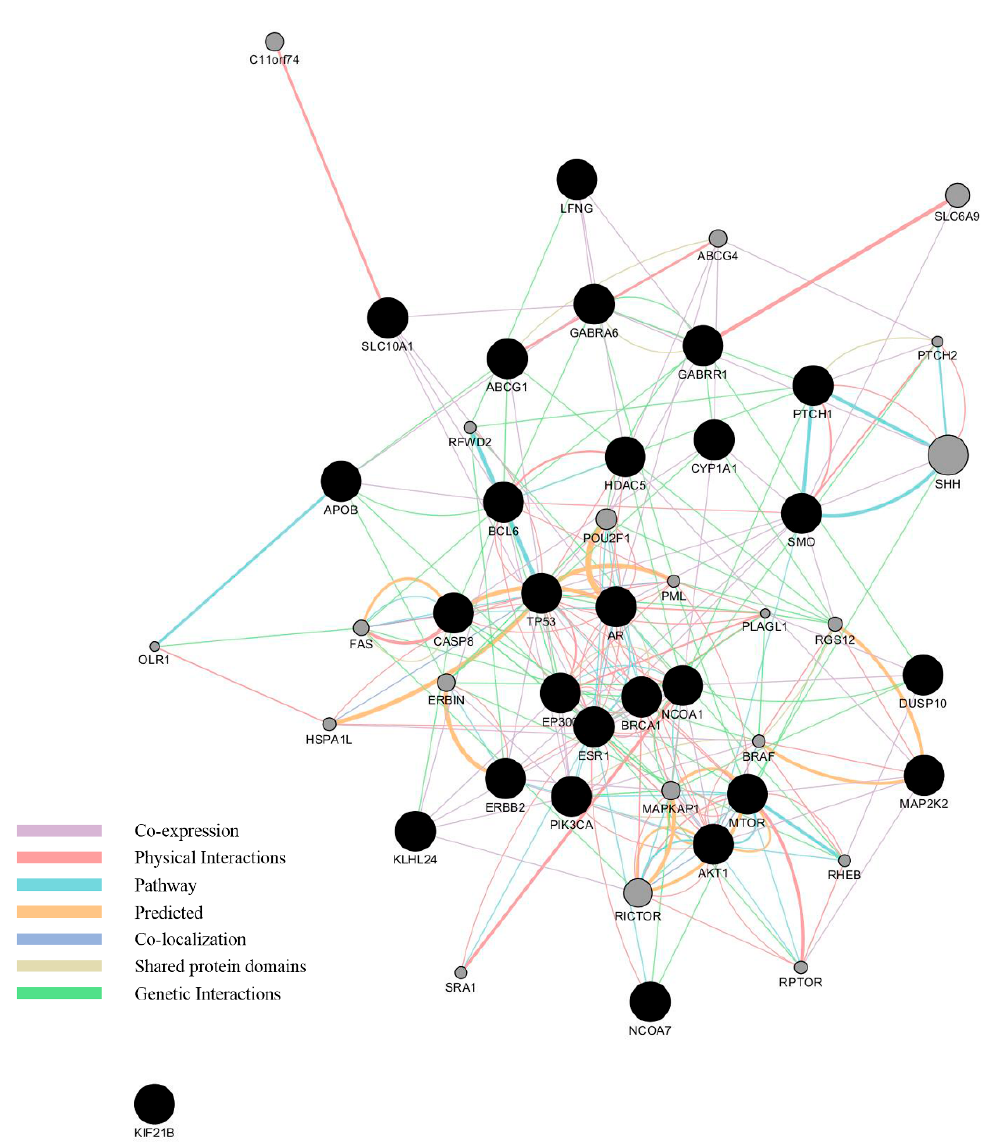
Figure 3. Network of the 27 common genes (black nodes) and the additional 20 predicted associated genes (gray nodes) by GeneMANIA. The node size of predicted genes represents the relevance of each gene to the 27 genes.